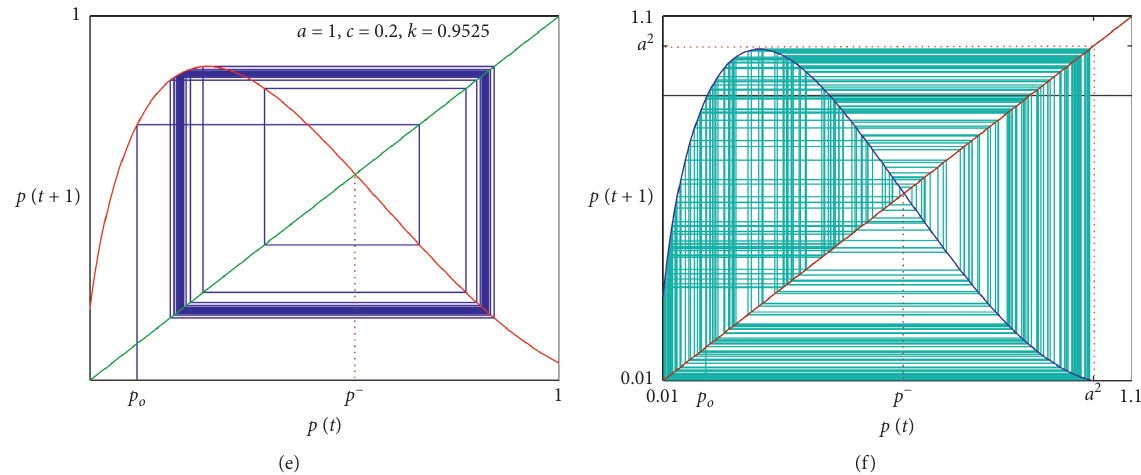
Figure 3: Bifurcation shape of p versus (a) k at a � 1 ,c � 0 . 2 , 0 . 5, (b) a at k � 0 . 5 ,c � 0 . 2 , 0 . 5, and (c) c at a � 1 , k � 0 . 5 , 0 . 7. Basins of attraction of different attracting set for the map (11) at the parameters set: (d) k � 0 . 2, (e) k � 0 . 9525, and (f) k � 1 . 11. Other parameters’ values are a � 1 , c � 0 .